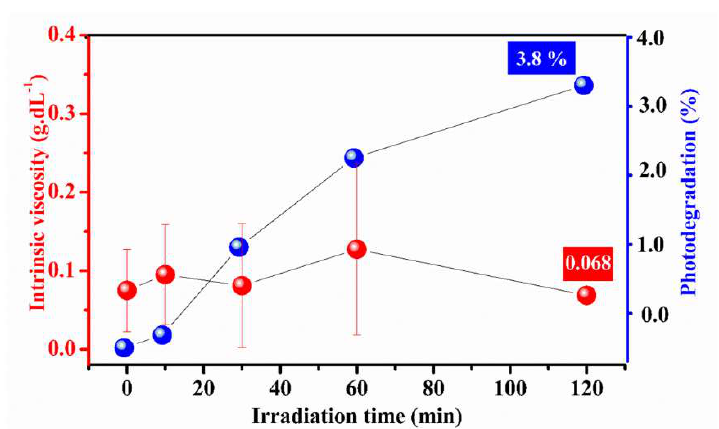
Figure 4. Intrinsic viscosity and photodegradation rate of EPSwk at different times of UV irradiation.